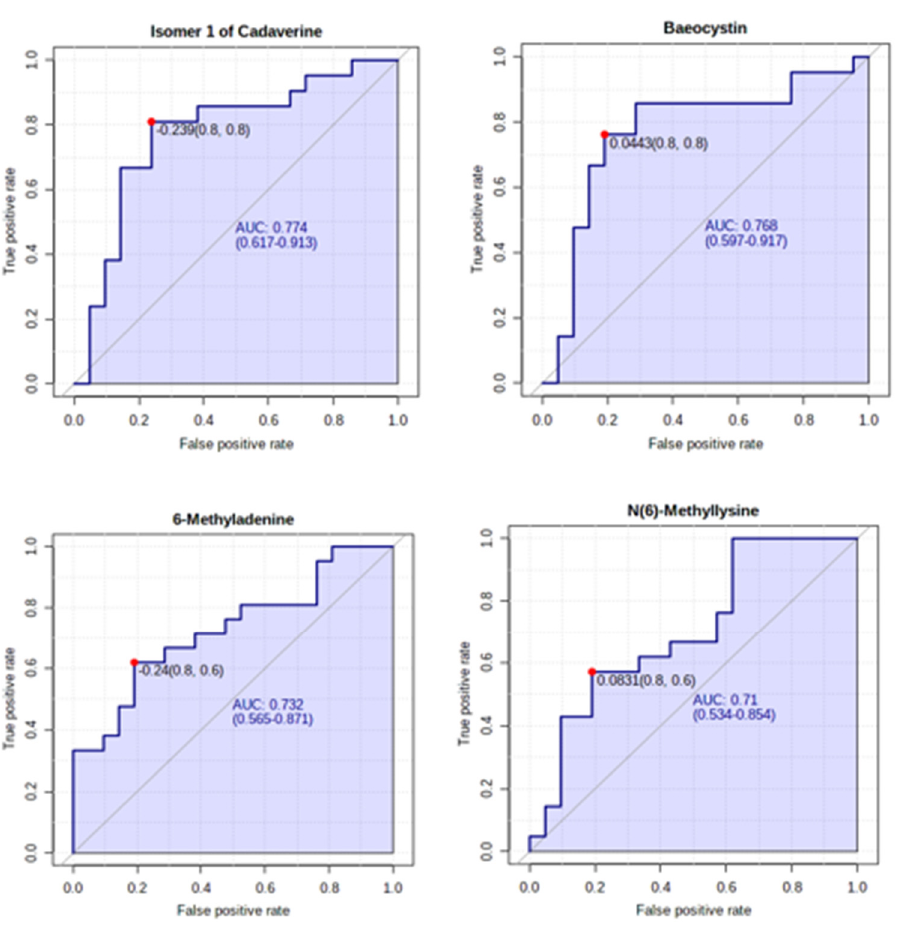
Figure 3. Biomarker analysis of metabolome in rumen fluid. ROC curve analysis of the four metabo- lites (isomer 1 of cadaverine, baeocystin, 6-methyladenine, N(6)-methyllysine) associated with diver- gent RFI phenotype.